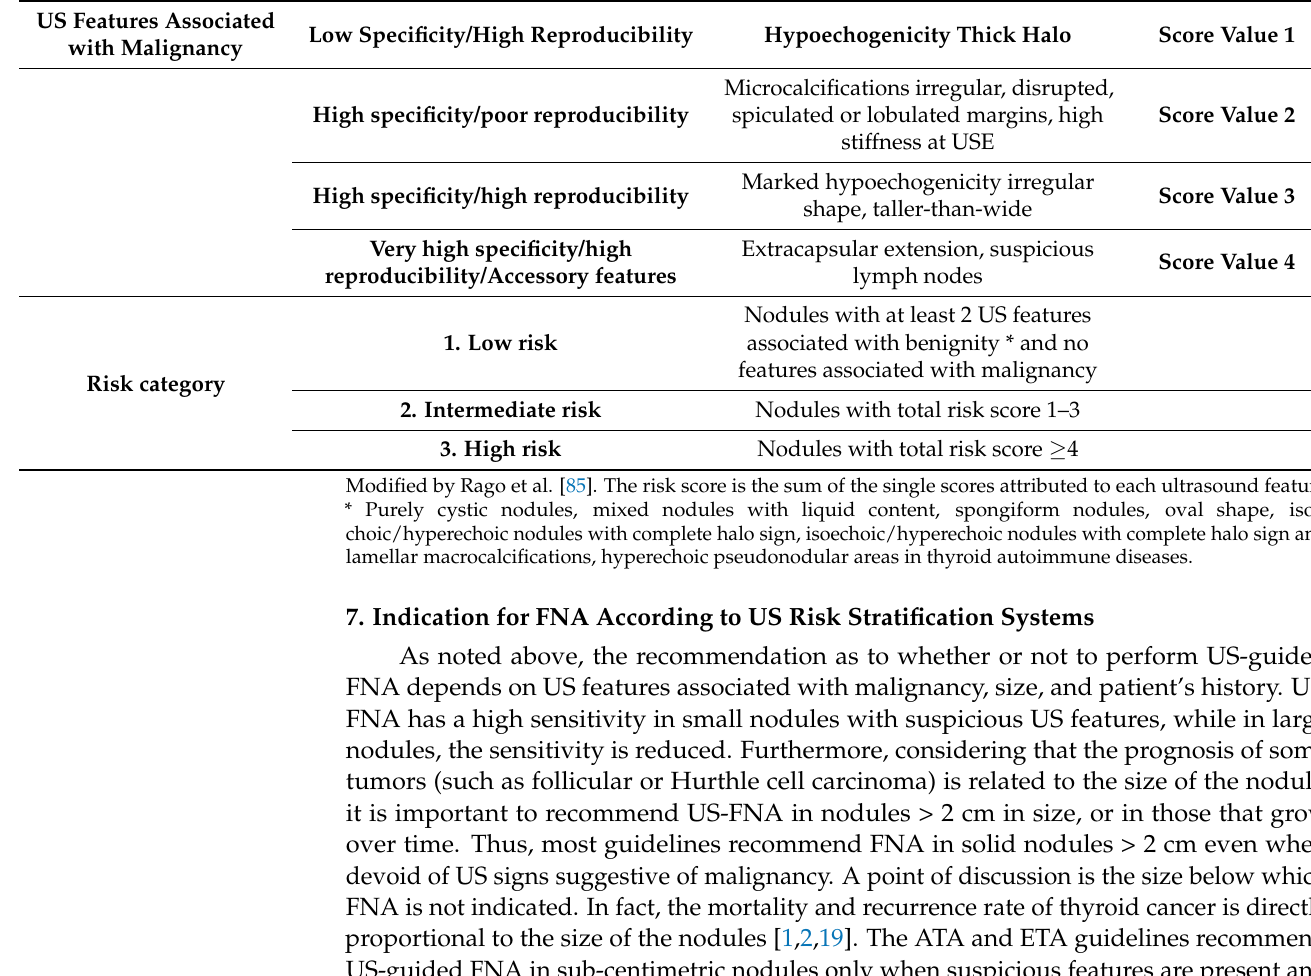
Table 1. Stratification of the risk score based on the predictive value of each US feature associated with